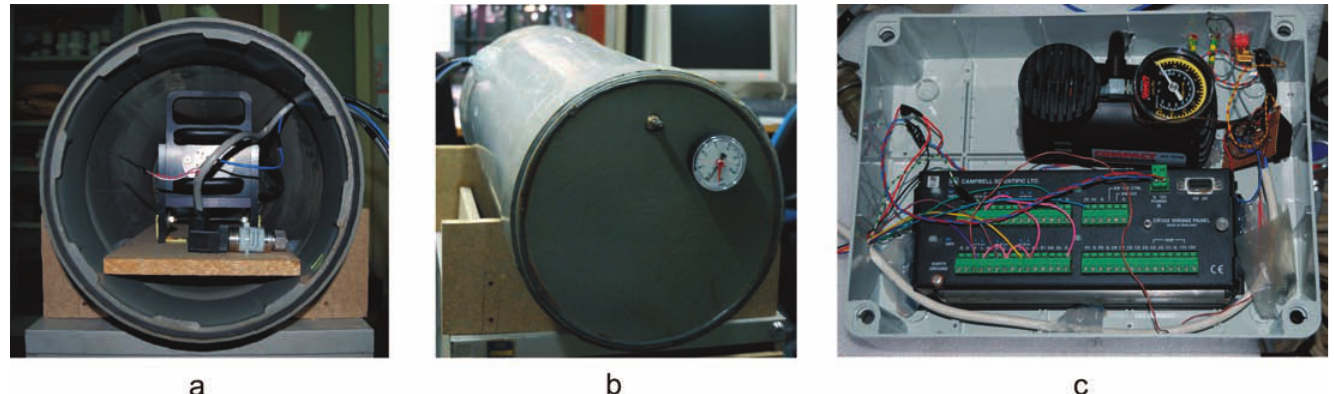
Figure 4. The hyperbaric chamber made from a PVC pipe. The laser, together with pressure (PTX 1400), temperature (LM 35) and humidity (HIH 3605) sensors, were placed inside the chamber (a, b). All of the signals were sampled at 1-min intervals and stored by a datalogger (CR10X). A 12 V compressor was installed for automatic adjustment around the operative pressure values threshold